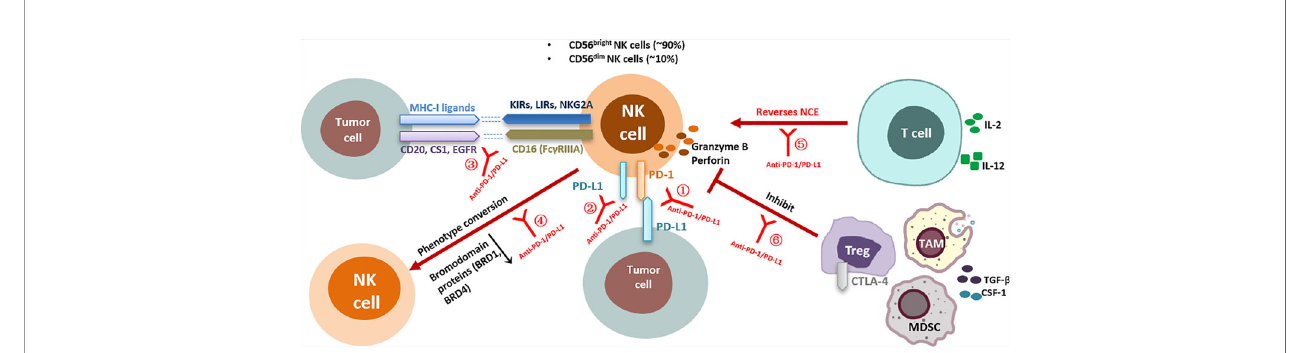
FIGURE 1 | Effects of anti-PD-1/PD-L1 antibodies on NK cell function and corresponding regulatory mechanisms. Direct interaction of anti-PD-1/PD-L1 antibodies with NK cells: ① Anti-PD-1/PD-L1 antibodies block PD-1/PD-L1 inhibitory signaling in NK cells; ② Anti-PD-1/PD-L1 antibodies enhance PD-L1 + NK-cell antitumor activity; ③ Anti-PD-1/ PD-L1 antibodies enhance the ADCC effect of NK cells; ④ Anti-PD-1/PD-L1 bispeci fi c antibodies induce phenotypic transformation of NK cells; Indirect interaction of anti-PD-1/ PD-L1 antibodies with NK cells: ⑤ Anti-PD-1/PD-L1 antibodies indirectly reverse NK cell exhaustion by affecting CD8 + T cell activity; ⑥ Anti-PD-1/PD-L1 antibodies relieve the inhibition of NK cell function by affecting Tregs. KIRs, killer cell immunoglobulin-like receptors; LIRs, leukocyte immunoglobulin-like receptors; NKG2A, natural killer group 2 A; CTLA-4, cytotoxicT-lymphocyte-associated protein 4; IL, interleukin; NCE, NK cell exhaustion; PD-1, programmed death receptor-1; PD-L1, programmed death-ligand 1; MHC, major histocompatibility complex; TGF- b , transformation growth factor- b ; IFN- g , interferon- g ; Tregs, regulatory T cells; CSF-1, colony-stimulating factor 1; EGFR, epidermal growth factor receptor; NK cell, natural killer cell; TAMs, tumor-associated macrophages; MDSCs, myeloid-derived suppressor